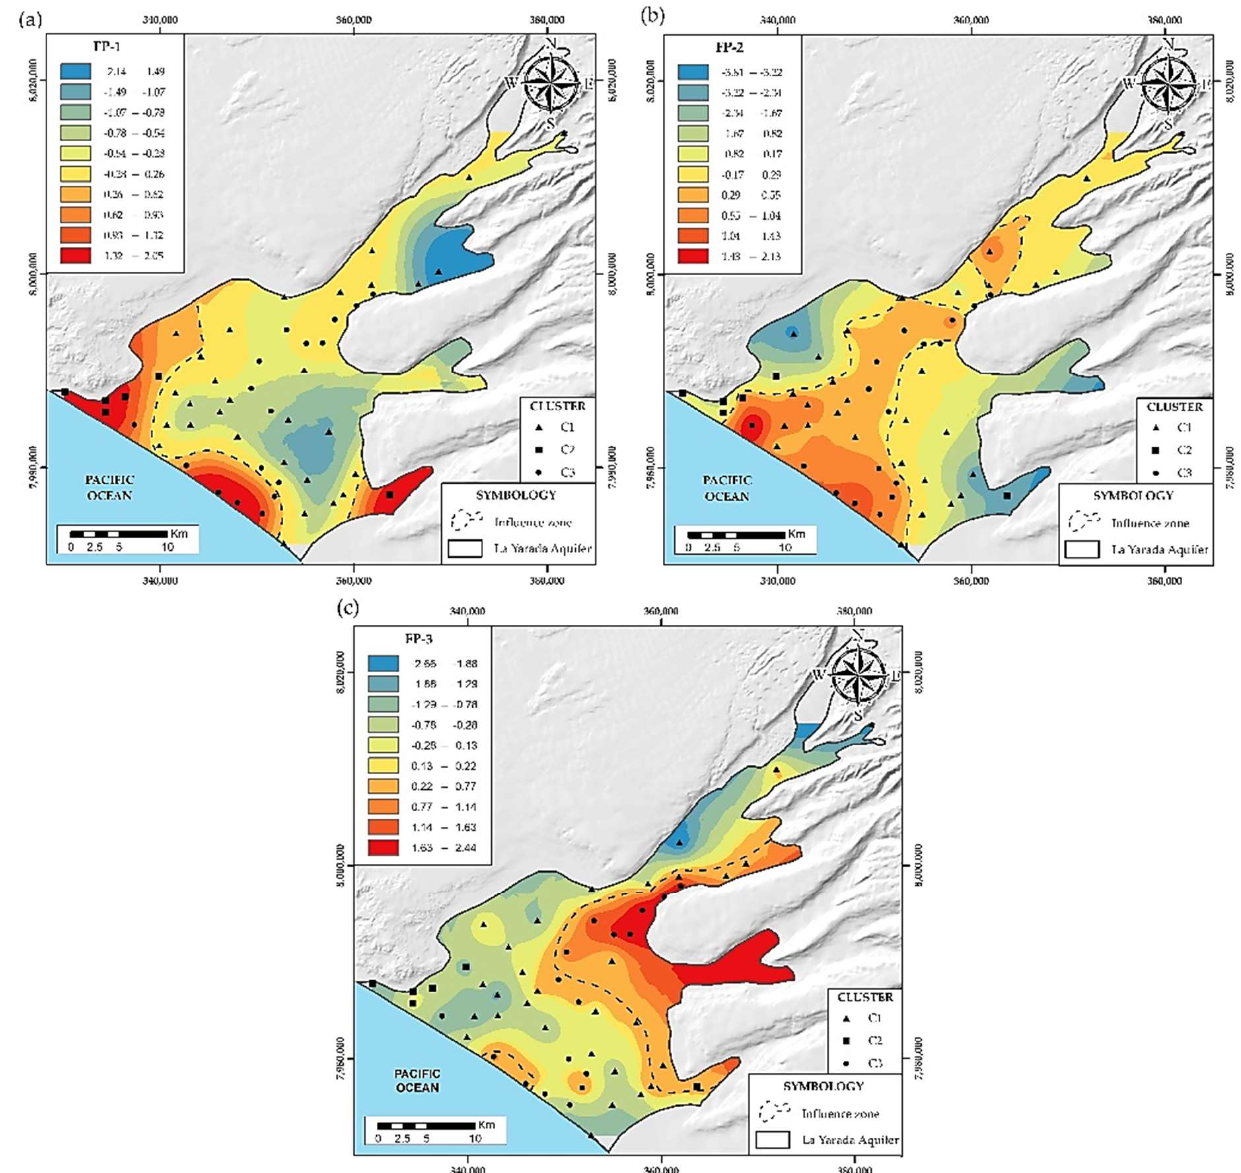
Figure 9. ( a ) Spatial distribution of factor FP-1. ( b ) Spatial distribution of factor FP-2. ( c ) Spatial distribution of factor FP-3.